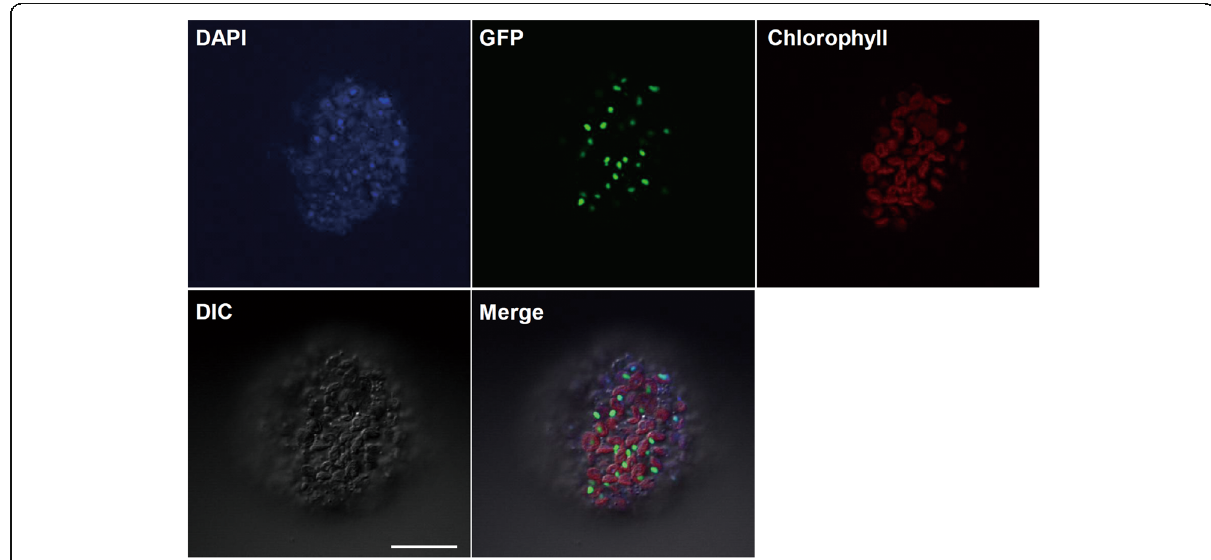
Fig. 6 OsObgC1 is localized in the chloroplast nucleoids. Localization of OsObgC1-GFP was examined in tobacco protoplasts by protoplast transient assay. After DAPI staining, DAPI fluorescence, GFP fluorescence and chlorophyll autofluorescence of transformed protoplasts were observed under a confocal microscopy. DIC (differential interference contrast) and Merge (DAPI + GFP+Chlorophyll) images are shown. “ Chlorophyll ” was used as a marker for to detect chloroplast distribution. The white bar in the DIC image represents 20 μ m in